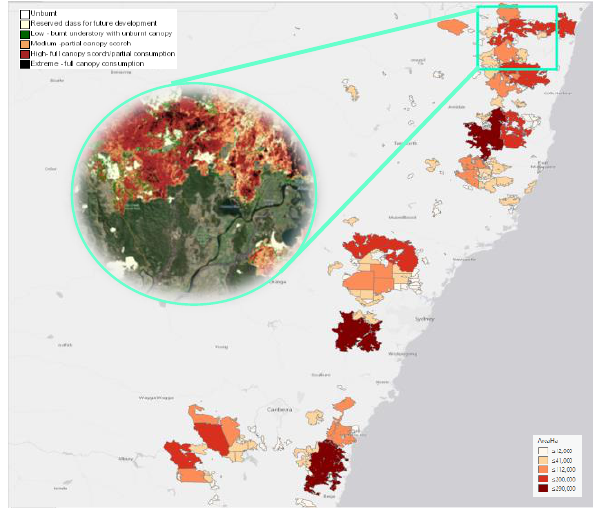
Figure 1. Location of study area in Myrtle Creek, NSW, Australia overlapped Fire Extent and Severity Mapping (FESM) (NSW Rural Fire Service 2020), and Google Earth Engine Burnt Area Map (GEEBAM) (Department of Planning 2020).